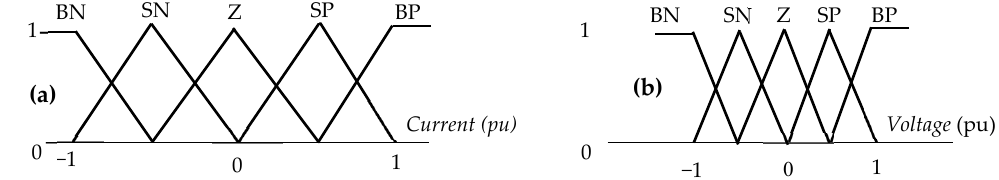
Figure 4. Membership functions of the input ( a ) and the output ( b ) of the proposed fuzzy-logic controller. Table 1. Rules for the fuzzy-logic controller.